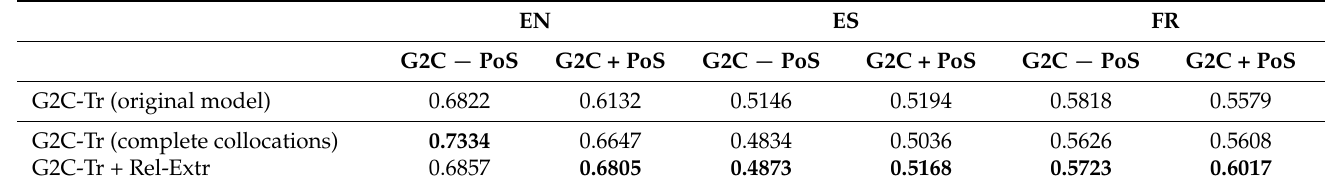
Table 6. Results of the evaluation of basic G2C-Tr model and the proposed extension by the rela- tion extraction-driven model (the best performance across the different models and languages is highlighted in